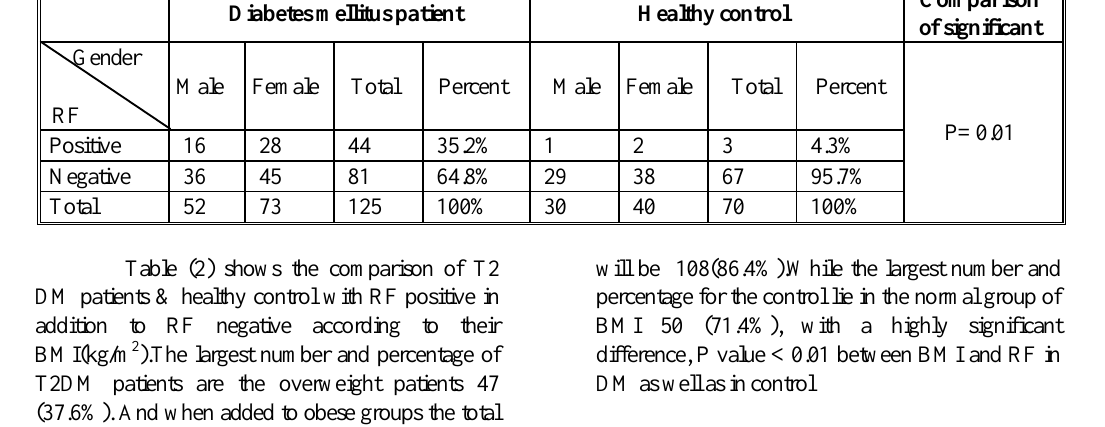
Table 1: Distribution of studied groups according to RF agglutination test Diabetes mellitus patient